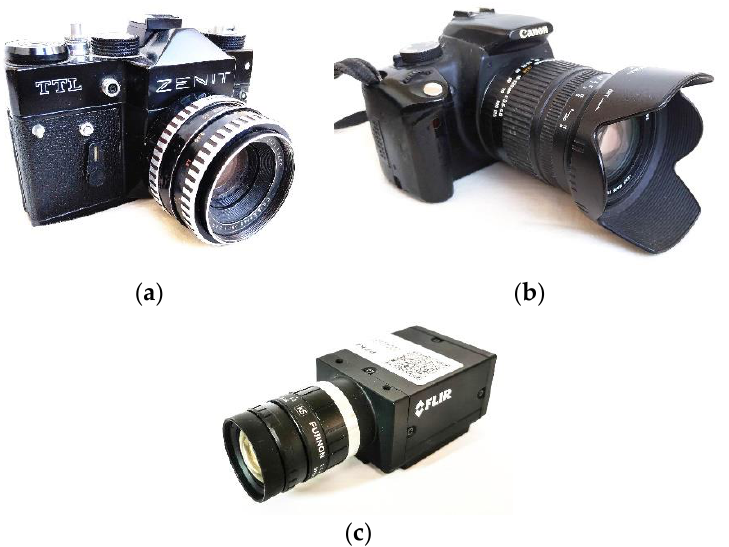
Figure 2. Cameras used for testing. ( a ) Zenit TTL (C1), ( b ) EOS 350D (C2), ( c ) Grasshopper3 (C3).